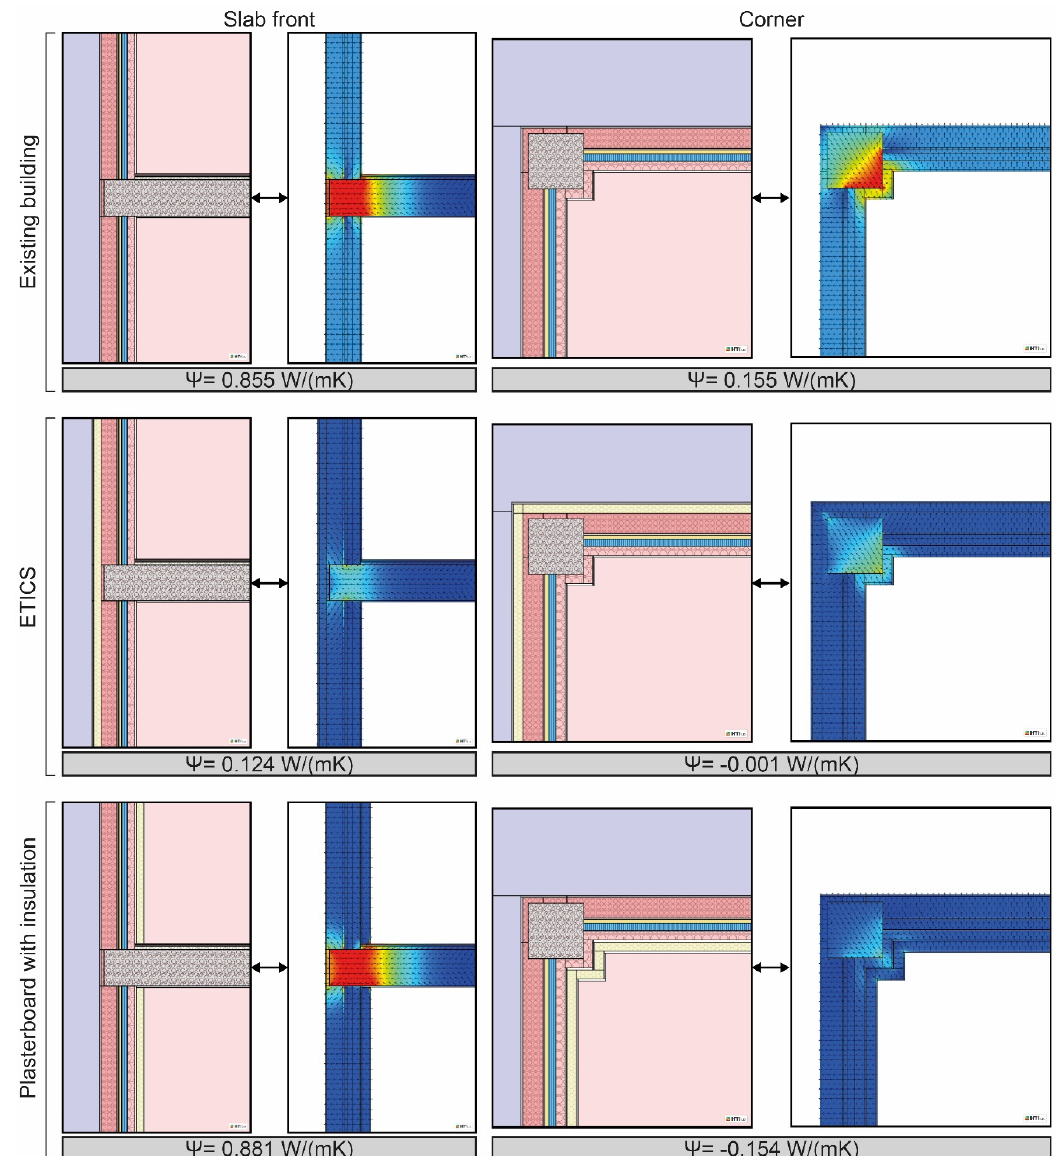
Figure 6. Simulation and linear thermal transmittance ( Ψ ) values of the thermal bridges in the building (both with the building envelope and the two improvements of the façade).